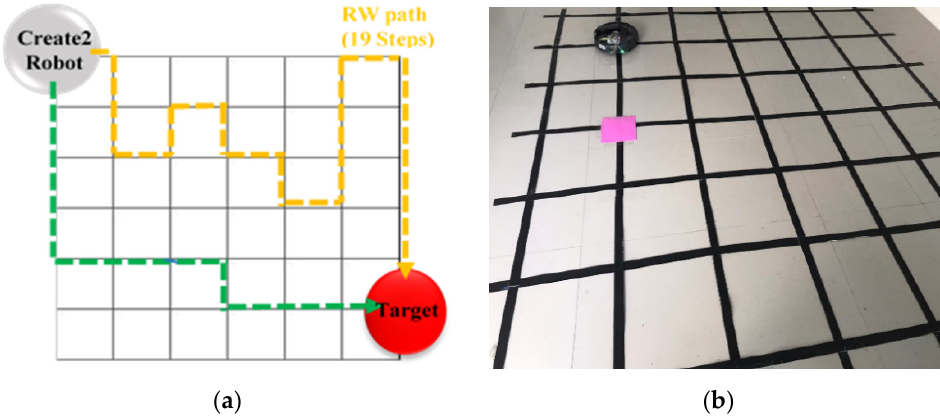
Figure 1. Experimental scenario. ( a ) Paths; ( b ) Real scenario with a 7 × 7 square